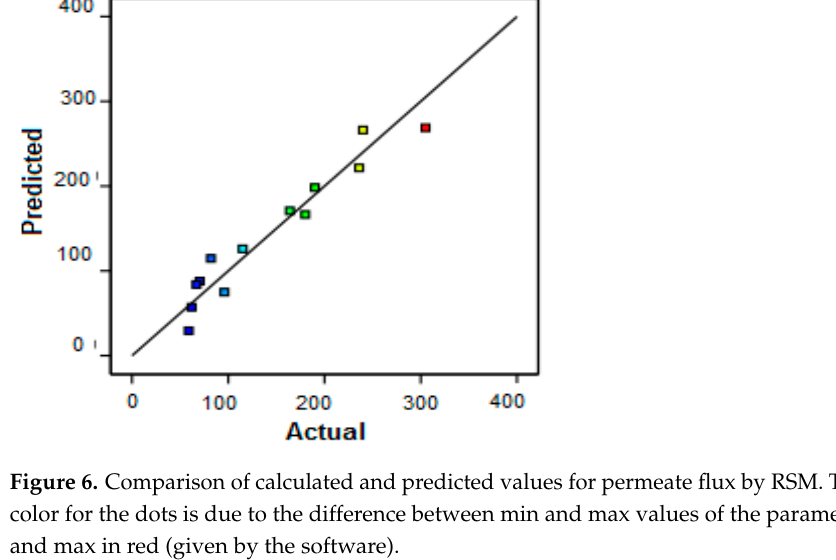
Figure 6. Comparison of calculated and predicted values for permeate flux by RSM. The difference of color for the dots is due to the difference between min and max values of the parameter: min in blue and max in red (given by the software).